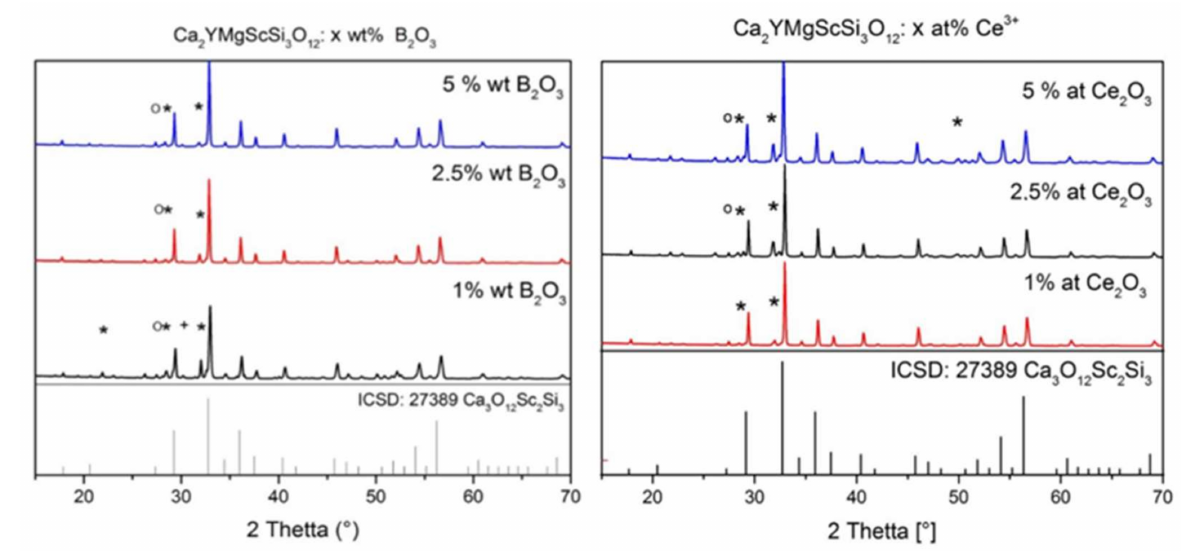
Figure 3. XRD patterns of CYMSSG:Ce MPs with different flux and activator amounts: ( a ) x wt.% B 2 O 3 and ( b ) x at.% CeO 2 , where * is Ca 2 Ce 8 O 26 Si 6 , + is SiO 2 , and o is YBO 3 . From the XRD data, a garnet phase with maxima corresponding mostly to Ca 3 Sc 2 Si 3 O